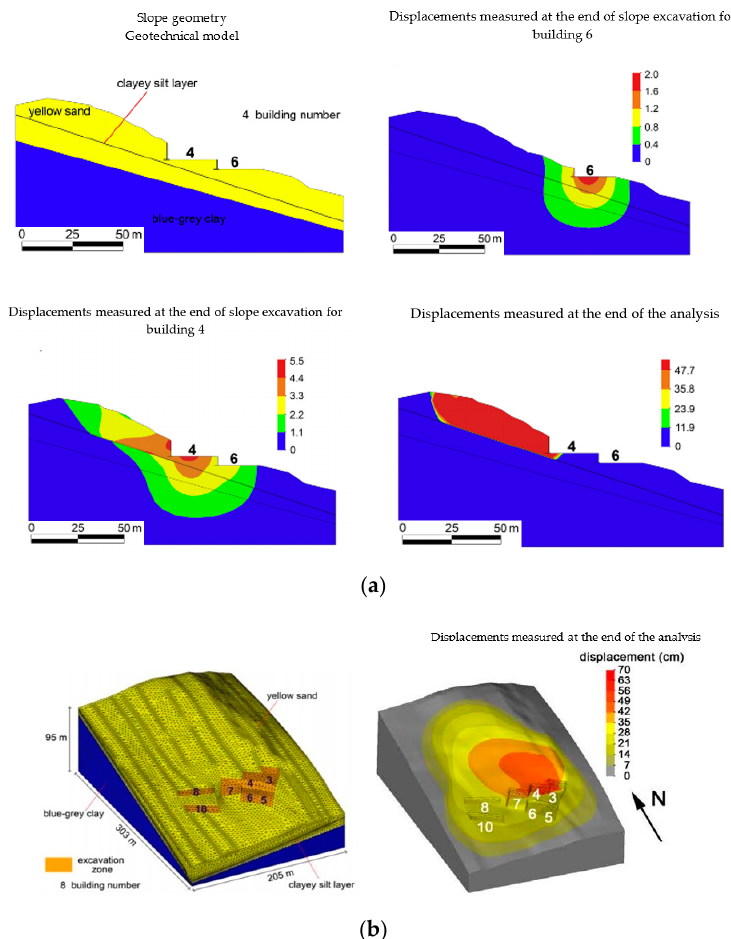
Figure 15. Timpone landslide: finite element numerical modelling performed by means of Tochnog code—2D (( a ); [72]) and 3D analyses (( b ); [73]). Table 5. Landslide factors of the Timpone landslide (class 3; Figure 11; [103,104]); Key: MF—silt fraction, SF—sand fraction, for the other acronyms referring to Table 3.